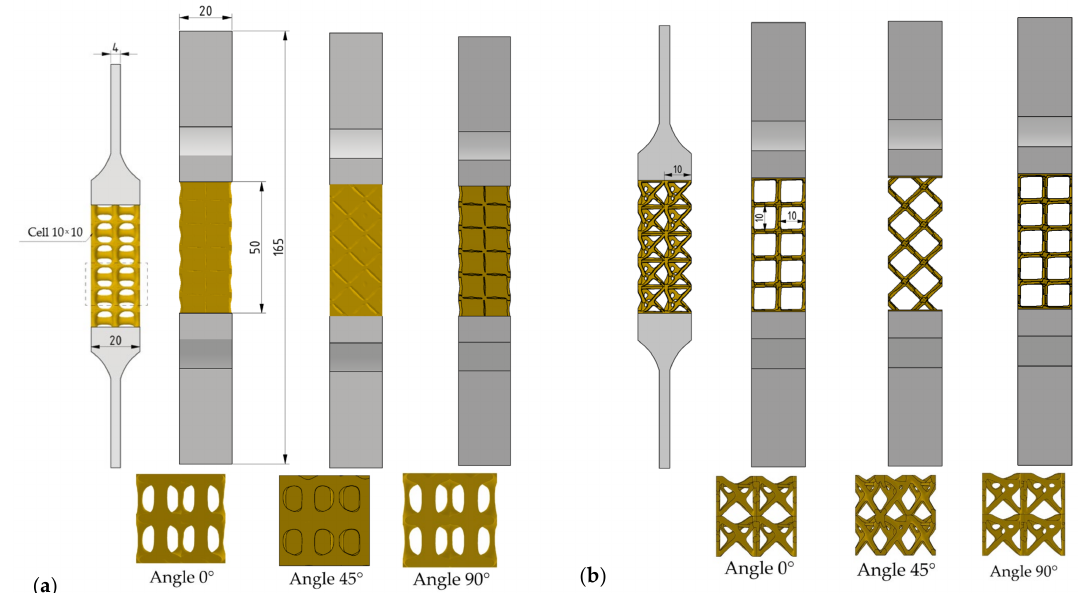
Figure 10. Outline dimensions of the tensile strength specimens ( a , b ), each lattice structure fabricated with 0 ◦ , 45 ◦ and 90 ◦ angles of single unit cell